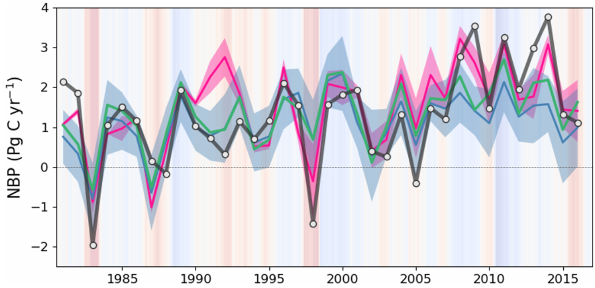
Figure 9. Global annual NBP between 1981 and 2016 from ED (black line), DGVMs from the GCB2020 (ensemble average shown as a blue line, with the ± 1 σ spread shown as blue shading), the ensemble of atmospheric inversions (ensemble average shown as a pink line, with the ± 1 σ spread shown as pink shading) and the terrestrial residual sink of the GCB2020 (green line). Positive val- ues indicate net carbon uptake from land. Background shading rep- resents the bimonthly Multivariate El Niño/Southern Oscillation (ENSO) index, where red indicates El Niño and blue indicates La Niña.